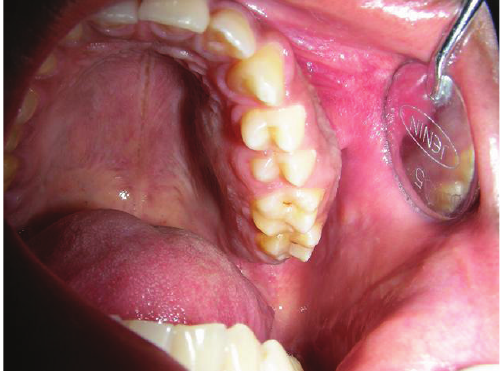
Figure 1: Lesion extension intraorally.